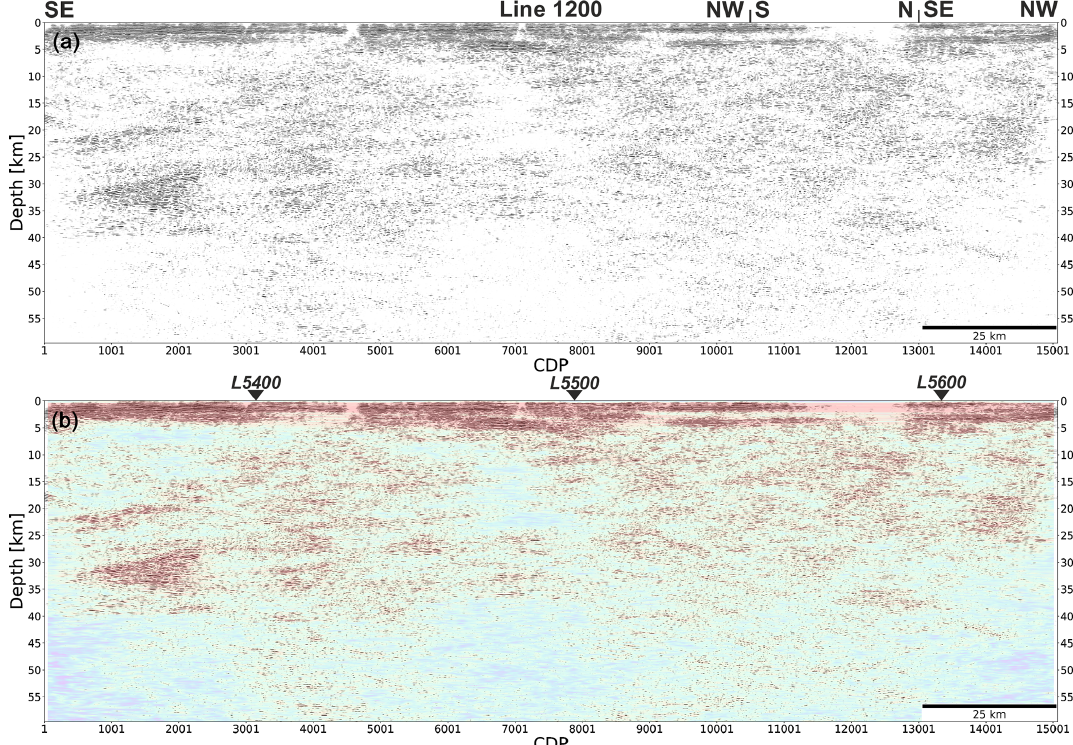
Figure 4. Final migrated depth-converted section along PolandSPAN ™ profile 1200: (a) plot of positive amplitudes; (b) plot of positive amplitudes with amplitude envelope attribute in the